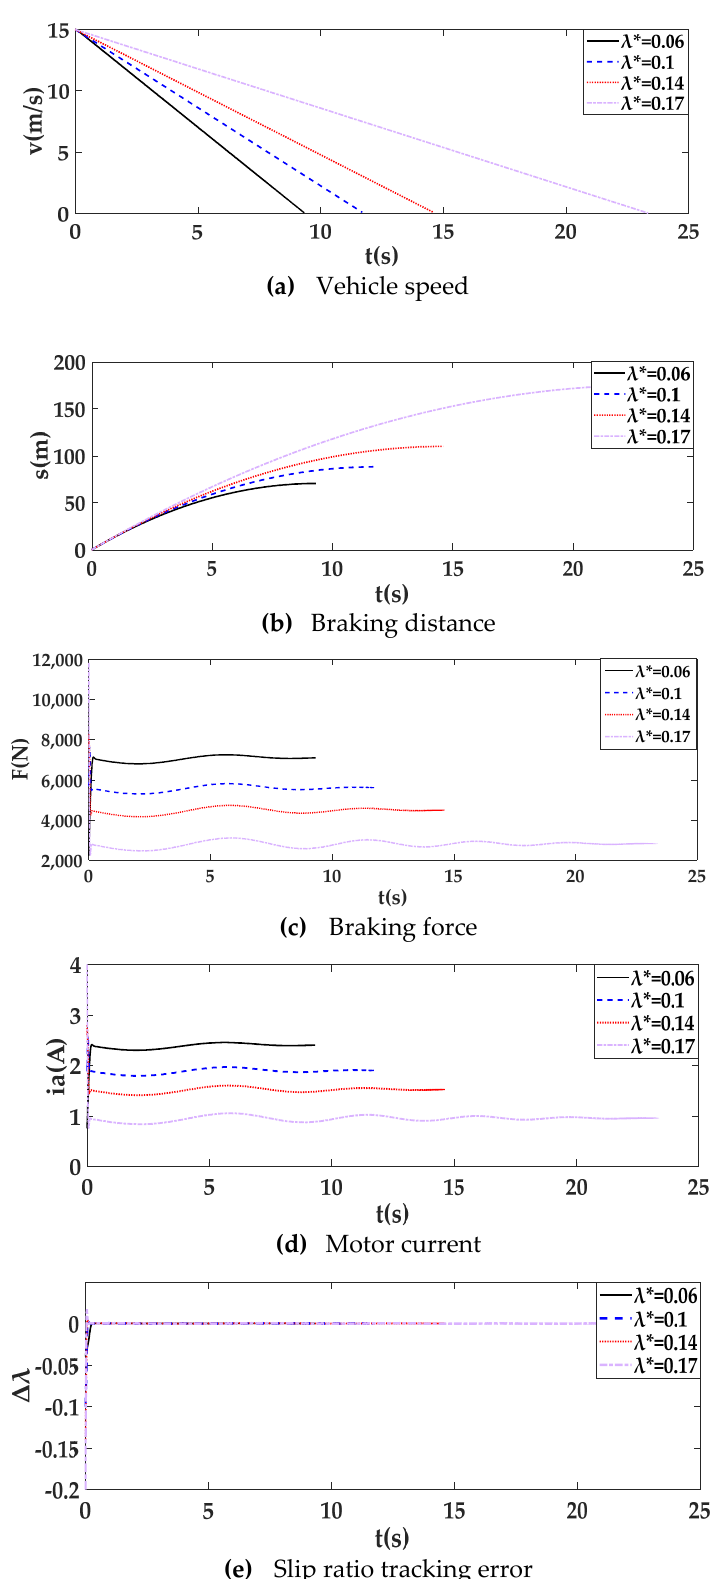
Figure 9. Cement road surface simulation.